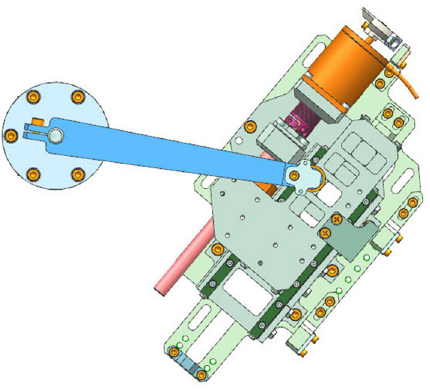
Figure 2. Structure diagram of wavelength scanning mechanism.